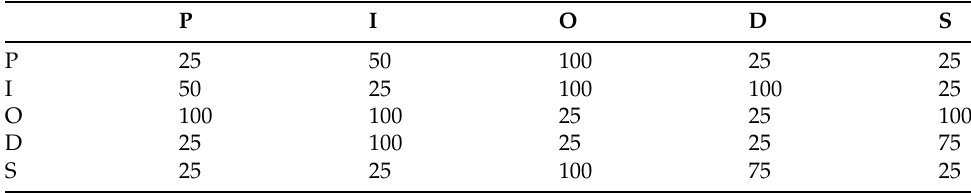
Table 1. Interaction parameters of the beads a ij (unit: k B T / r c ).